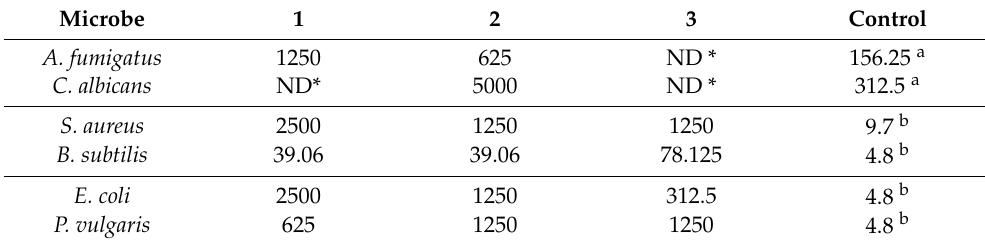
Table 6. MIC values ( µ g/mL) for the studied compounds.